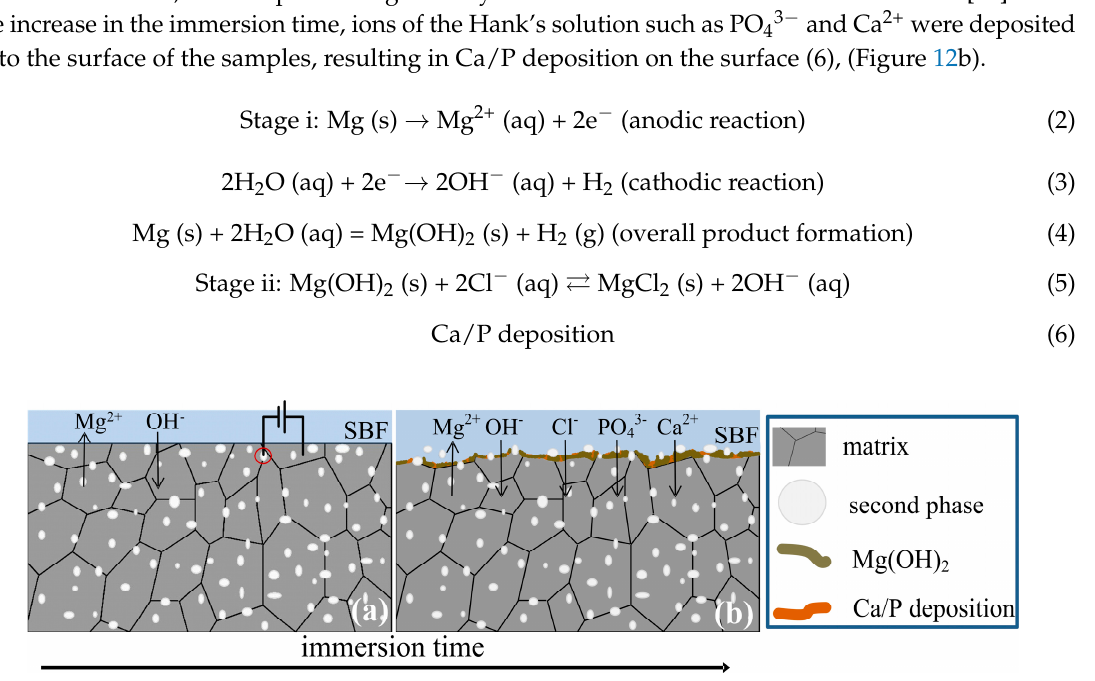
Figure 12. Schematic mechanism of the corrosion process of hot-rolled Mg − xSn − 1Zn − 0.5Ca (x = 1, 3 and 5 wt.%) alloys in simulated body fluid.